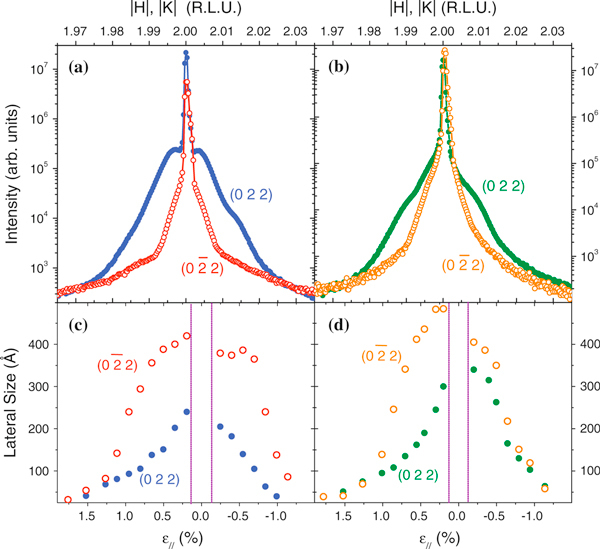
Radial scans at the vicinity of the GaAs (022) (solid dots) and (02¯2) (open dots) reflections for sample A (a) and B (b). Lateral size from iso-strain regions in samples A (c) and B (d) obtained from the width of transversal scans.